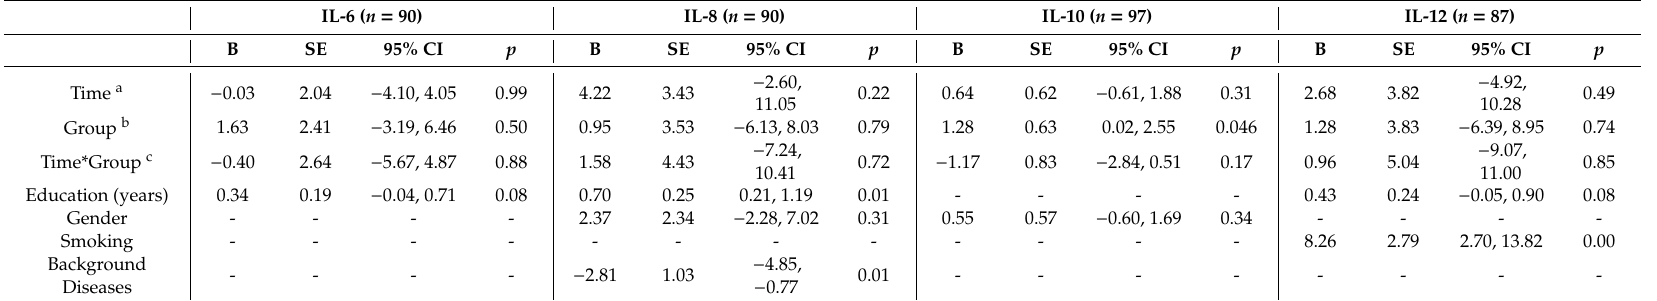
Table 3. Linear mixed e ff ect regression (LMM) models for predicting cytokine concentrations (pg / mL).